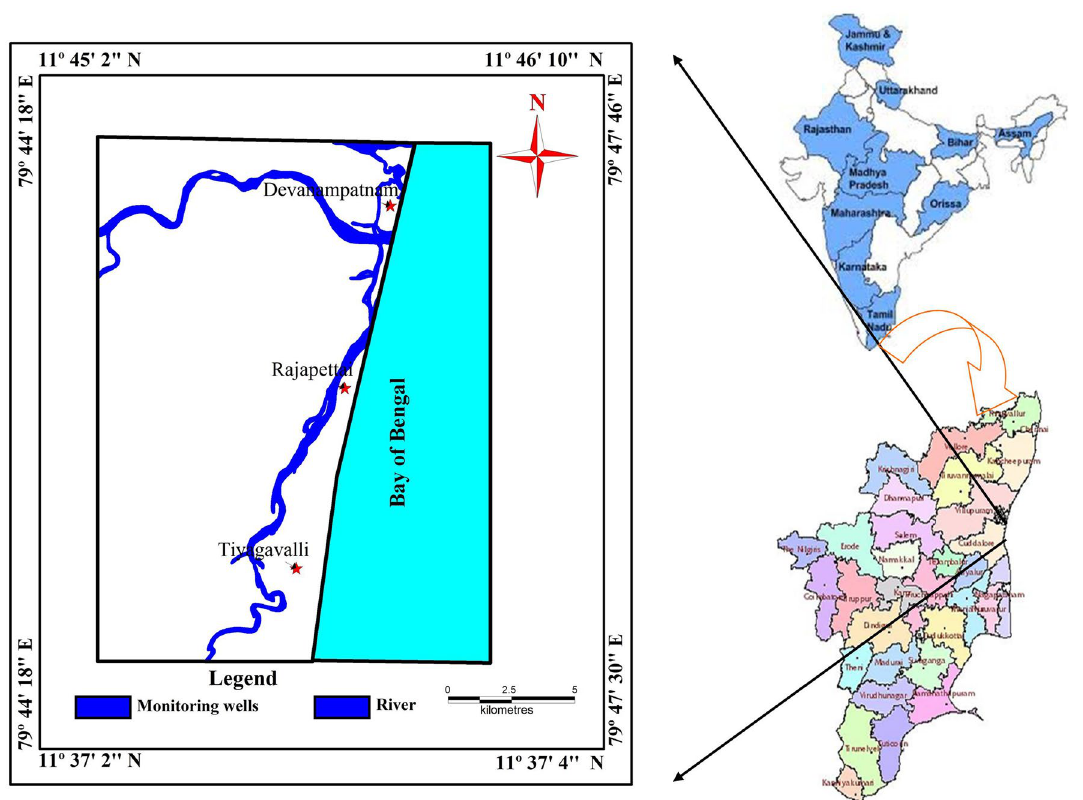
Fig. 1 Monitoring well of the study